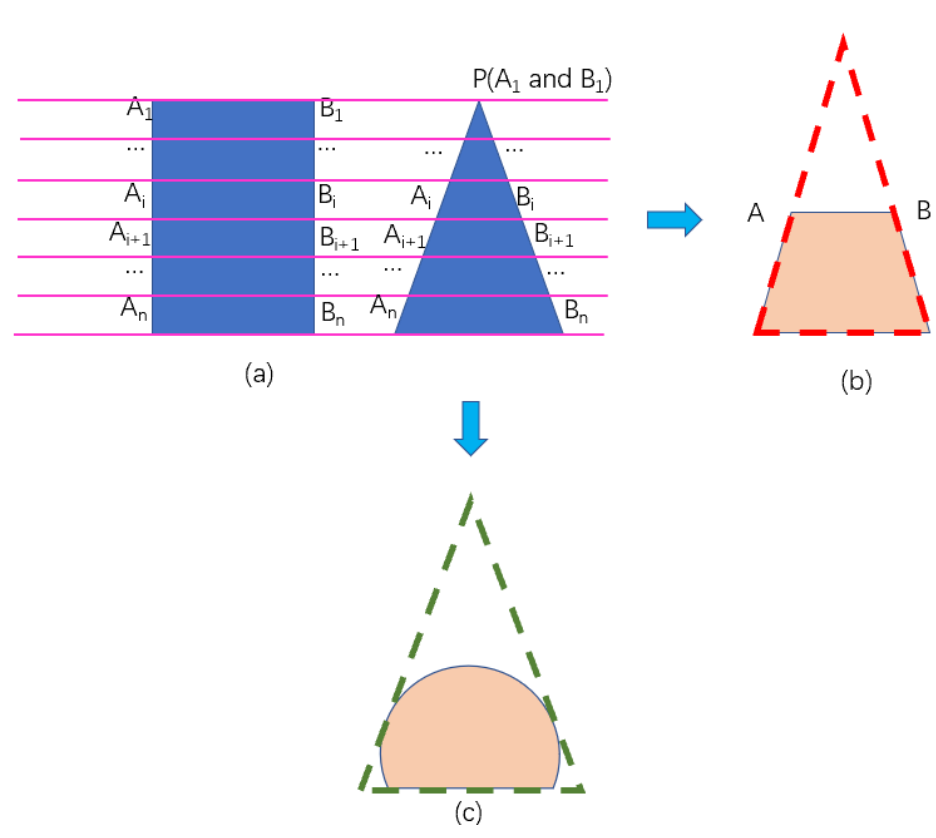
Figure 14. The processing of the tree crown shape fitting. ( a ) The intersection of the parallel line and the line segments of the key points. ( b ) The trapezoid is finally confirmed from triangle. ( c ) The sector is finally confirmed from triangle.